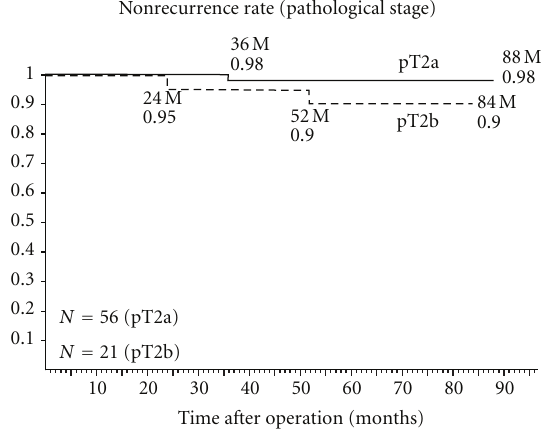
Figure 2: Actuarial biological non-recurrence rate of each patho- logical stage.